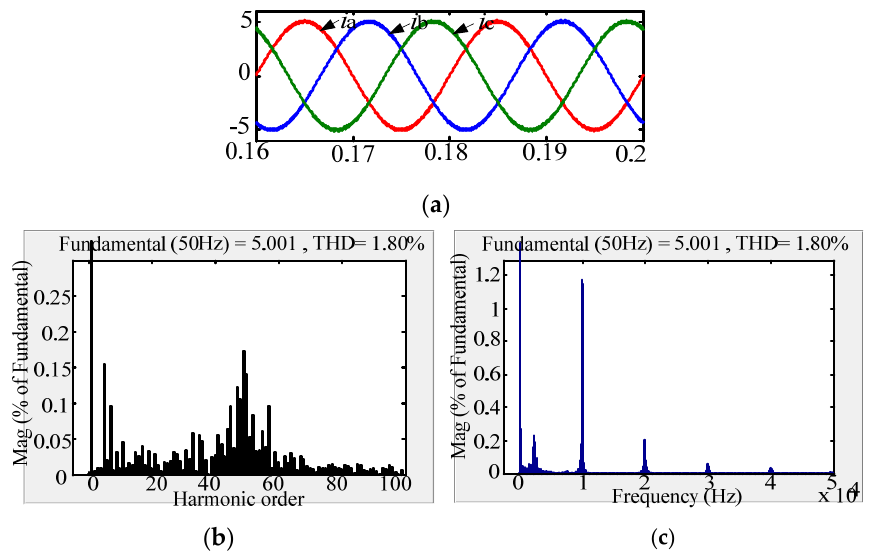
Figure 12. AC-side current waveform of split inductor damping solution 2. ( a ) AC-side current; ( b ) Low-frequency harmonic FFT analysis; ( c ) High-frequency harmonic FFT analysis.